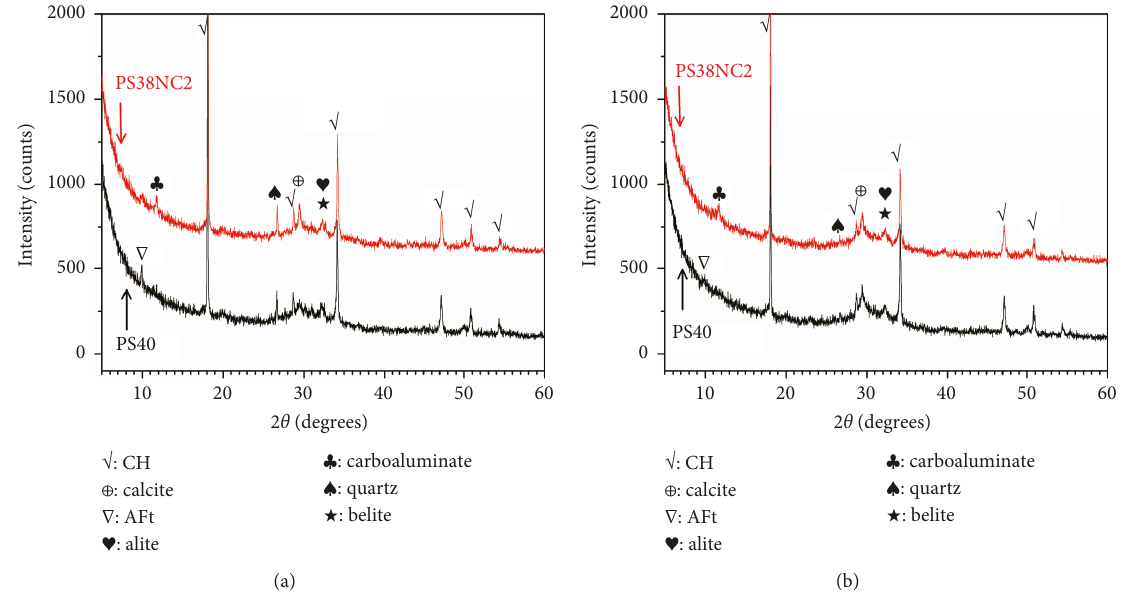
Figure 4: XRD pattern of specimens. (a) Hydration for 28days; (b) hydration for 90days.